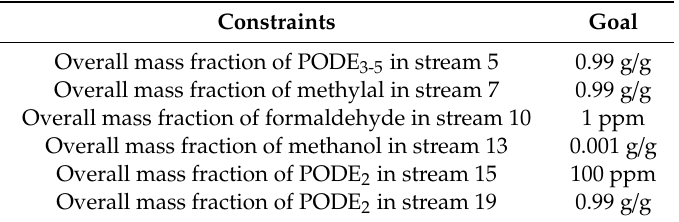
Table 1. Constraints used for the optimization of the process.